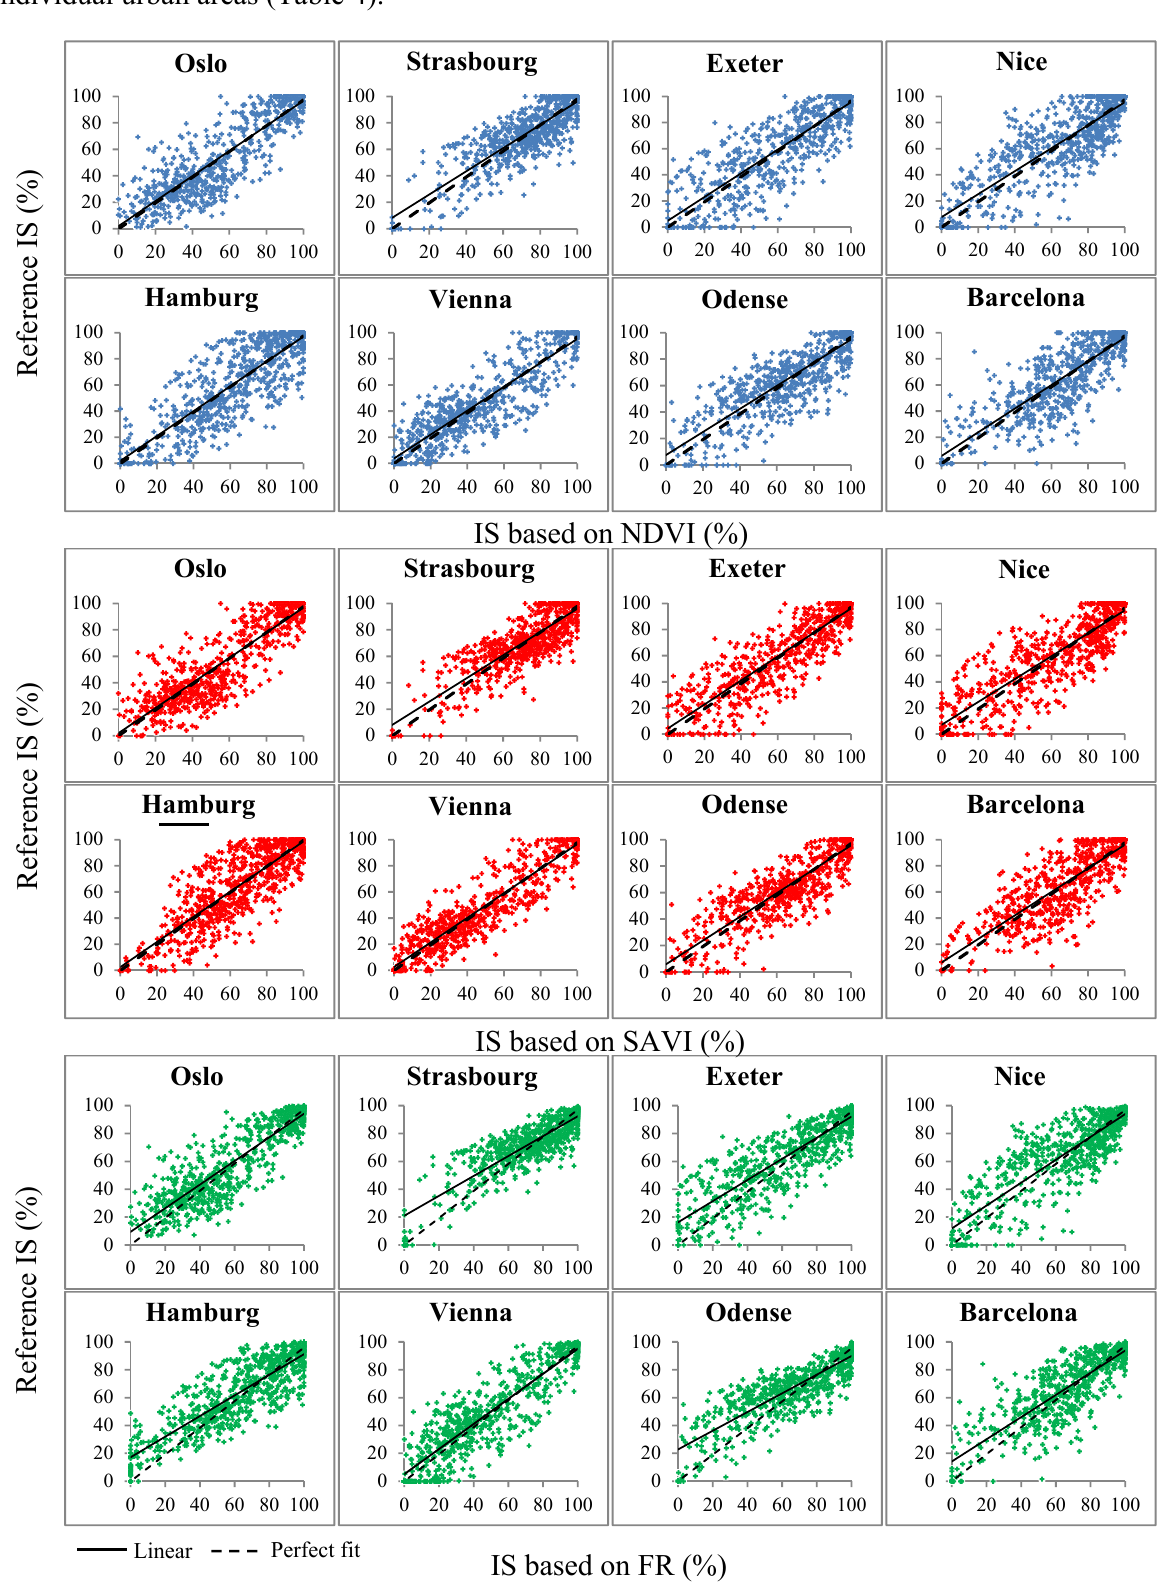
Figure 6. Relationship between reference IS fractions and estimates based on NDVI/SAVI/FR. Results are shown for the second order polynomial regression models for NDVI and